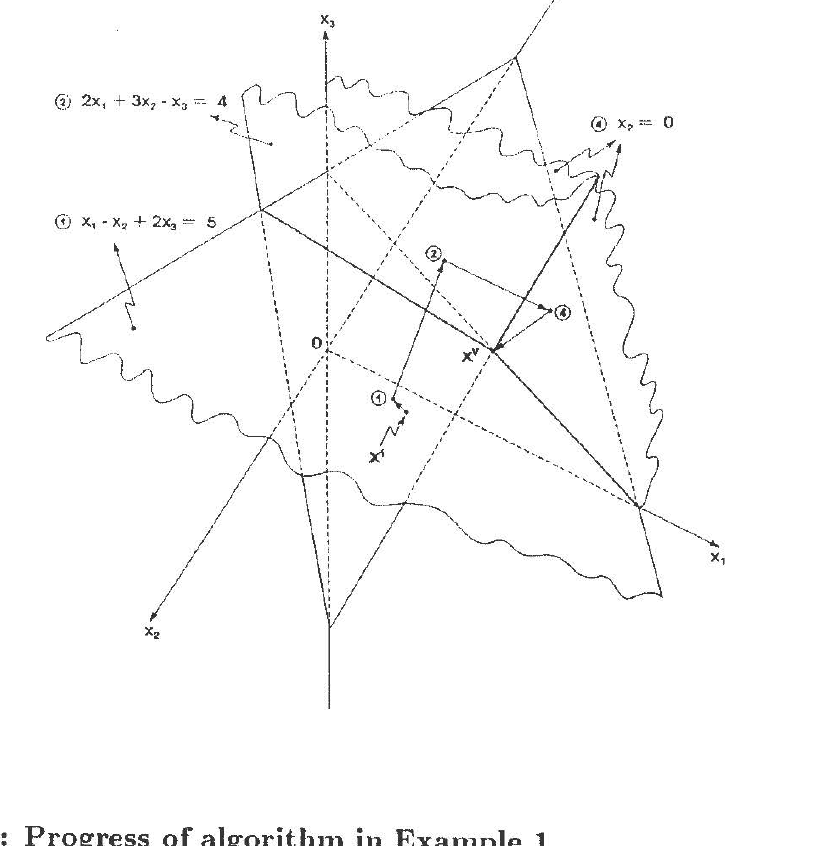
Figure 1: Progress of algorithm in Example 1